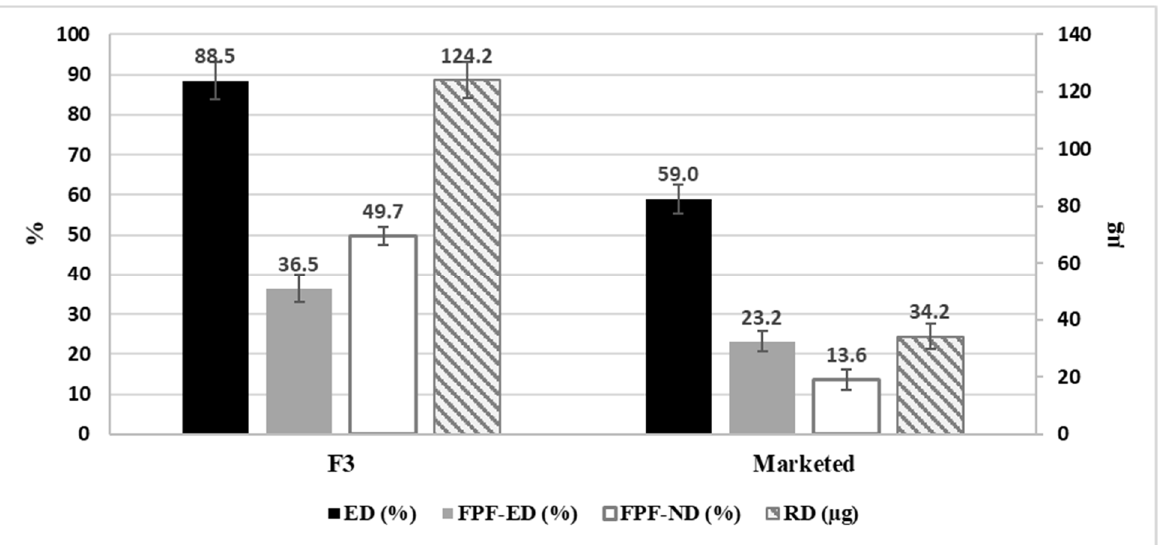
Figure 7. Aerodynamic behavior of FP from Formula F3 containing (FP-SAL/Lys-PA) NCs, high- lighting the main parameters for the formulation. ED: emitted dose; FPF-ED: fine particle fraction of emitted dose; FPF-ND: fine particle fraction of nominated dose; RD: respirable dose. Results are presented as mean ± SD, n =